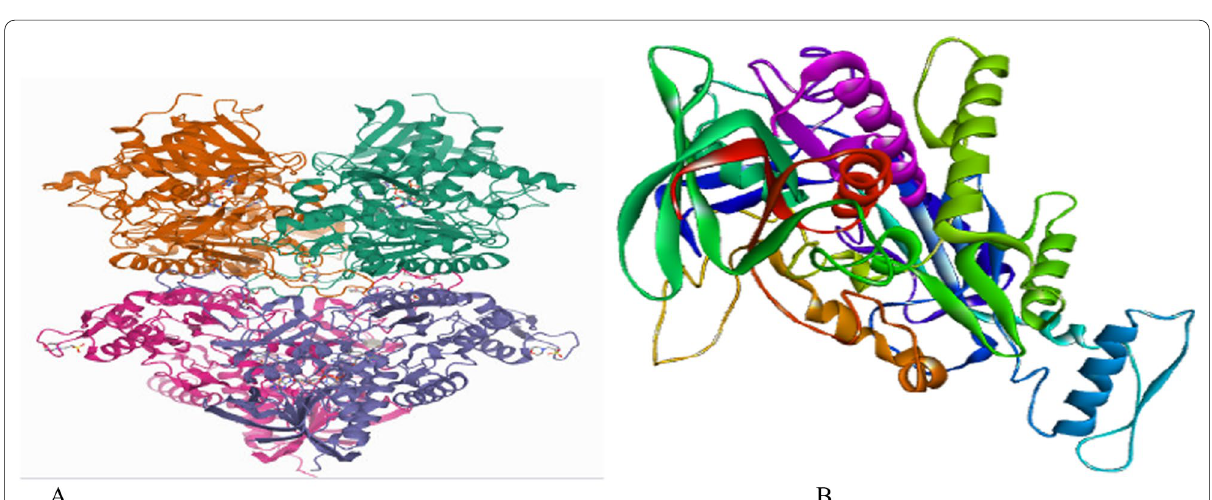
Fig. 1 A Protein target (4MOE) and B prepared